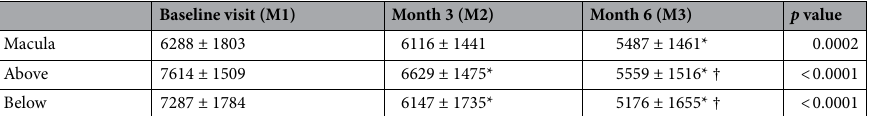
Table 2. The mean area (± standard deviation) of the outer plexiform layer (OPL) among patients with tubercular serpiginous-like choroiditis (TB SLC) measured using semi-automated quantitative techniques on optical coherence tomography line scans. The data is represented in mean pixel square (area) of the outer plexiform layer. The analysis is performed using one-way repeated measures analysis of variance (ANOVA). * p < 0.05 vs baseline visit (using post-hoc Tukey’s test). † p < 0.05 vs month 3 visit (using post-hoc Tukey’s